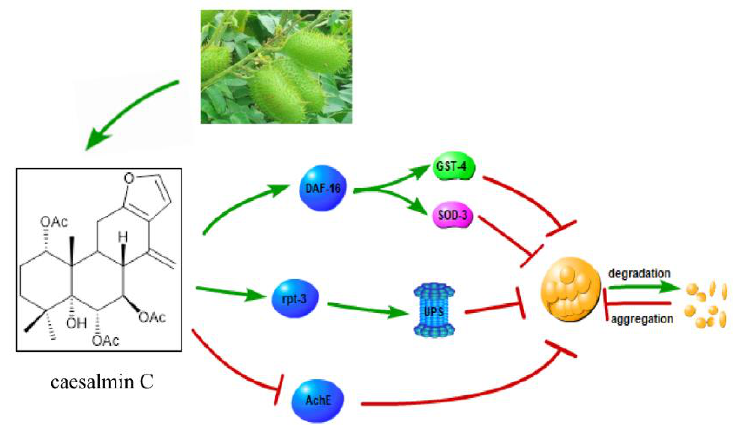
Figure 6. Schematic diagram of caesalmin C resistance to A β -induced toxicity in nematodes. The three pathways shown resist A β -induced toxicity by promoting the degradation of highly toxic A β oligomers or by inhibiting the aggregation of less toxic A β into highly toxic oligomers.